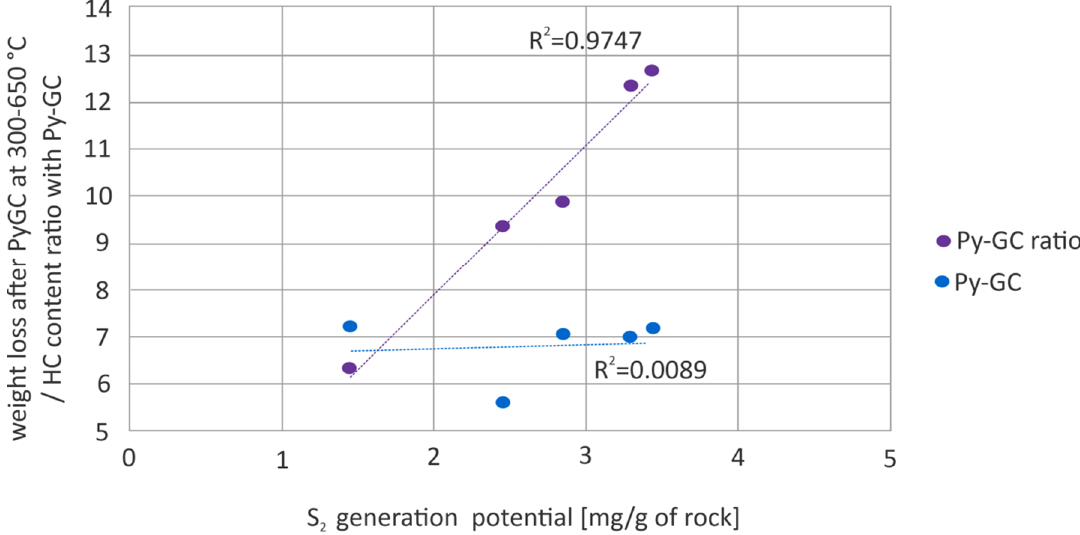
Figure 13. Correlation between the S 2 generation potential and Py/GC pyrolysis parameters in the temperature range of 300–650 °C for core samples from the Istebna Beds.